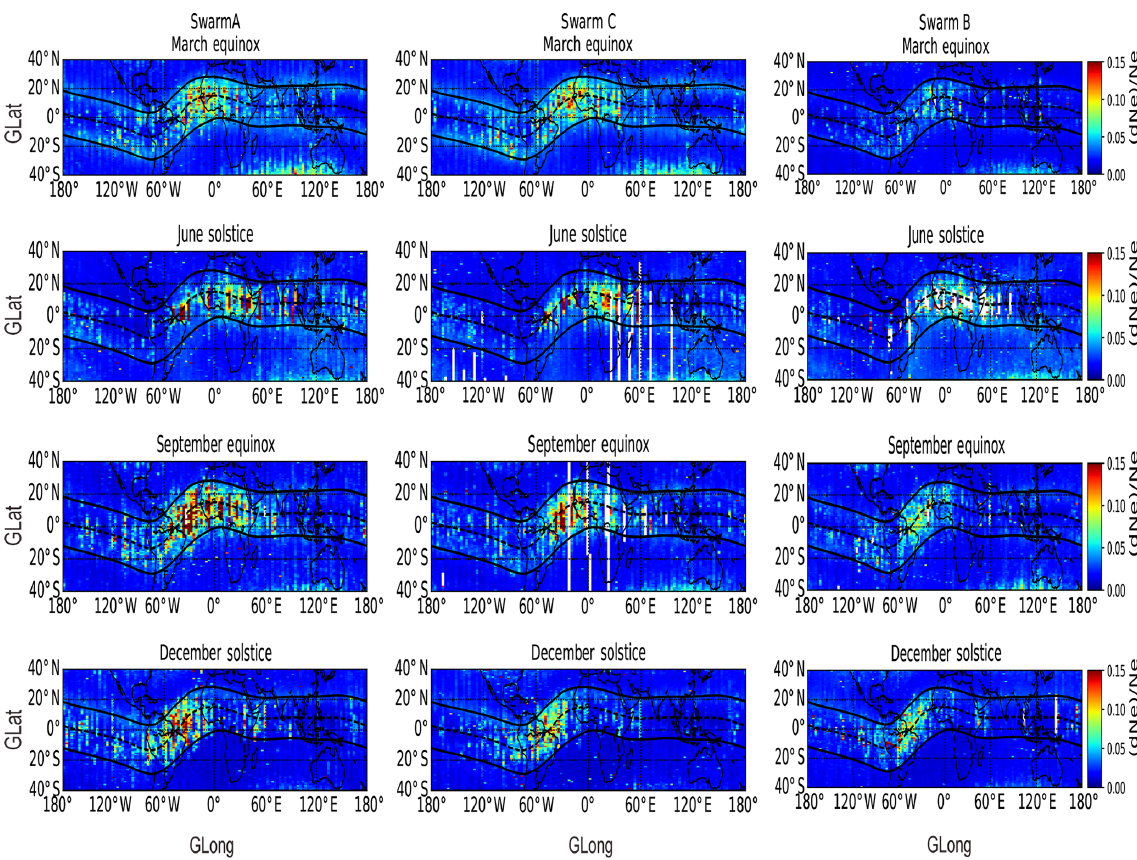
Figure 7. Relative electron density perturbation ( dN e /N e ) separated into four seasons (March or September equinox and June or December solstice) from October 2014 to October 2018 for Swarm A, C and B. The black dotted line represents the magnetic equator, while the black solid lines represent the EIA belts at about ± 15 ◦ of magnetic latitude. For each panel of a season, the colour scales represent dN e /N e